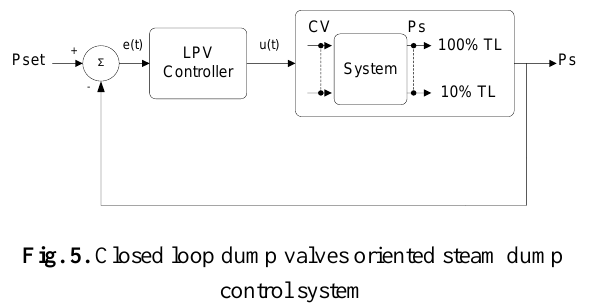
Fig. 7. Framework of closed loop FO-LPV-RSW-H∞ steam dump